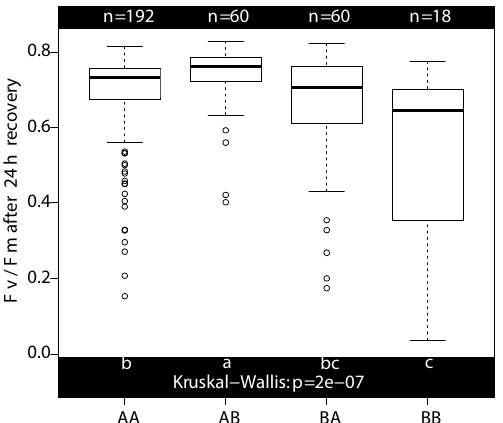
Figure 6. FT of 55 barley varieties sampled in the field in February 2008, assessed with F v /F m after freezing tests and 24 h of recovery. n = number of measurements = 6 replicates × N , with N = number of genotypes. AA, AB, BA and BB refer to the Nure (A) and Tremois (B) alleles for the VRN-H1 and VRN-H2 vernalization genes